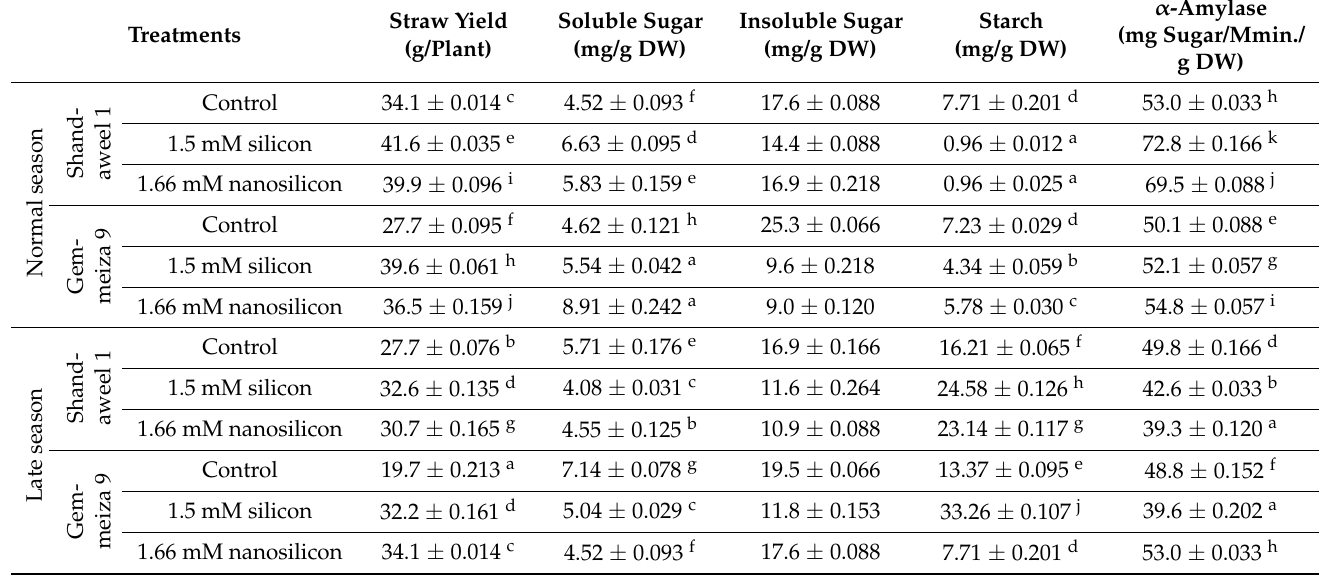
Table 7. Effects of silicon and nanosilicon on the straw yield quality of two wheat cv. Shandaweel 1 and cv. Gemmeiza 9 at normal and late seasons. Each value is the main of three different replicates ±